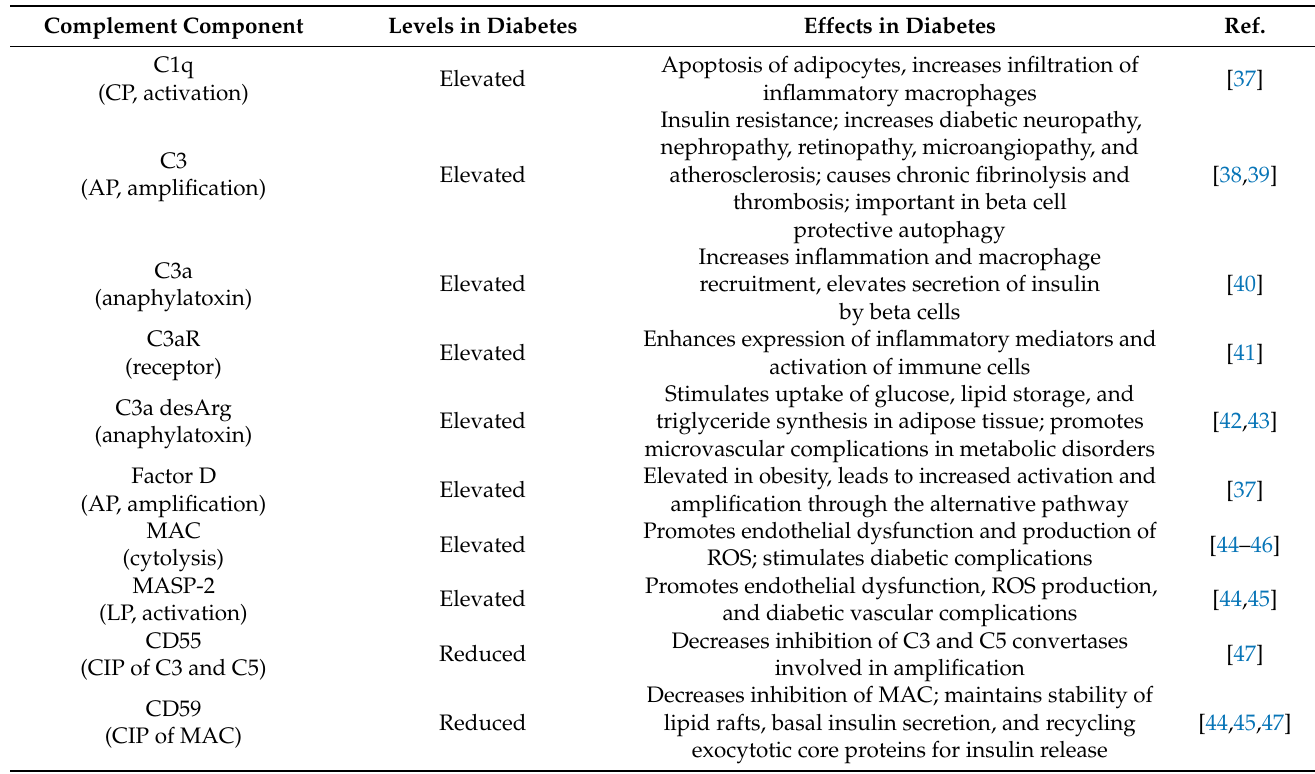
Table 3. Complement components in diabetes